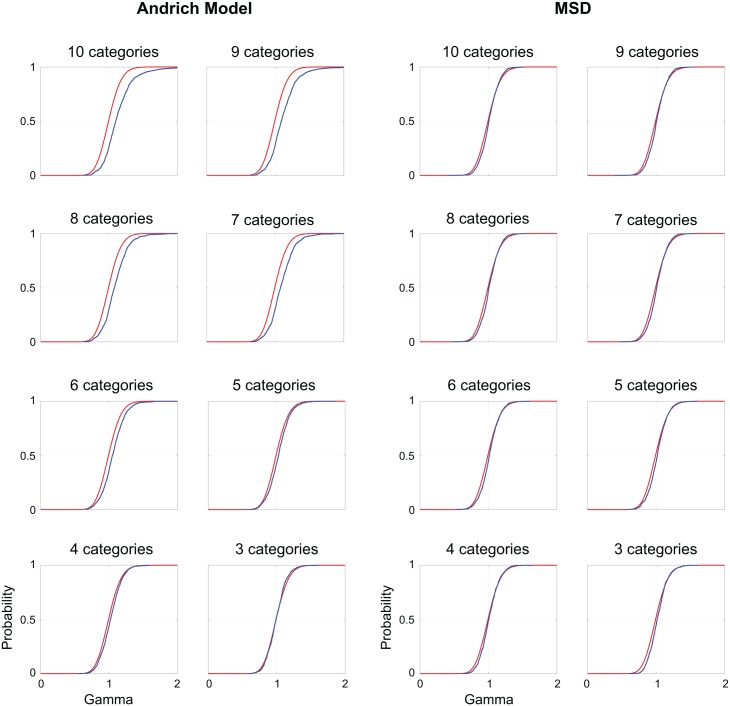
Comparing person infit mean squares for the Andrich model and MSD.Cumulative distribution functions of the person infit mean squares (blue curves) are compared to cumulative distribution functions of chi square divided by degrees of freedom (red curves), for the Andrich model (left) and MSD (right). The red and blue curves should be identical under the assumption that the only source of variance is random error. MSD satisfies this assumption better than the Andrich model as the number of rating categories increases.